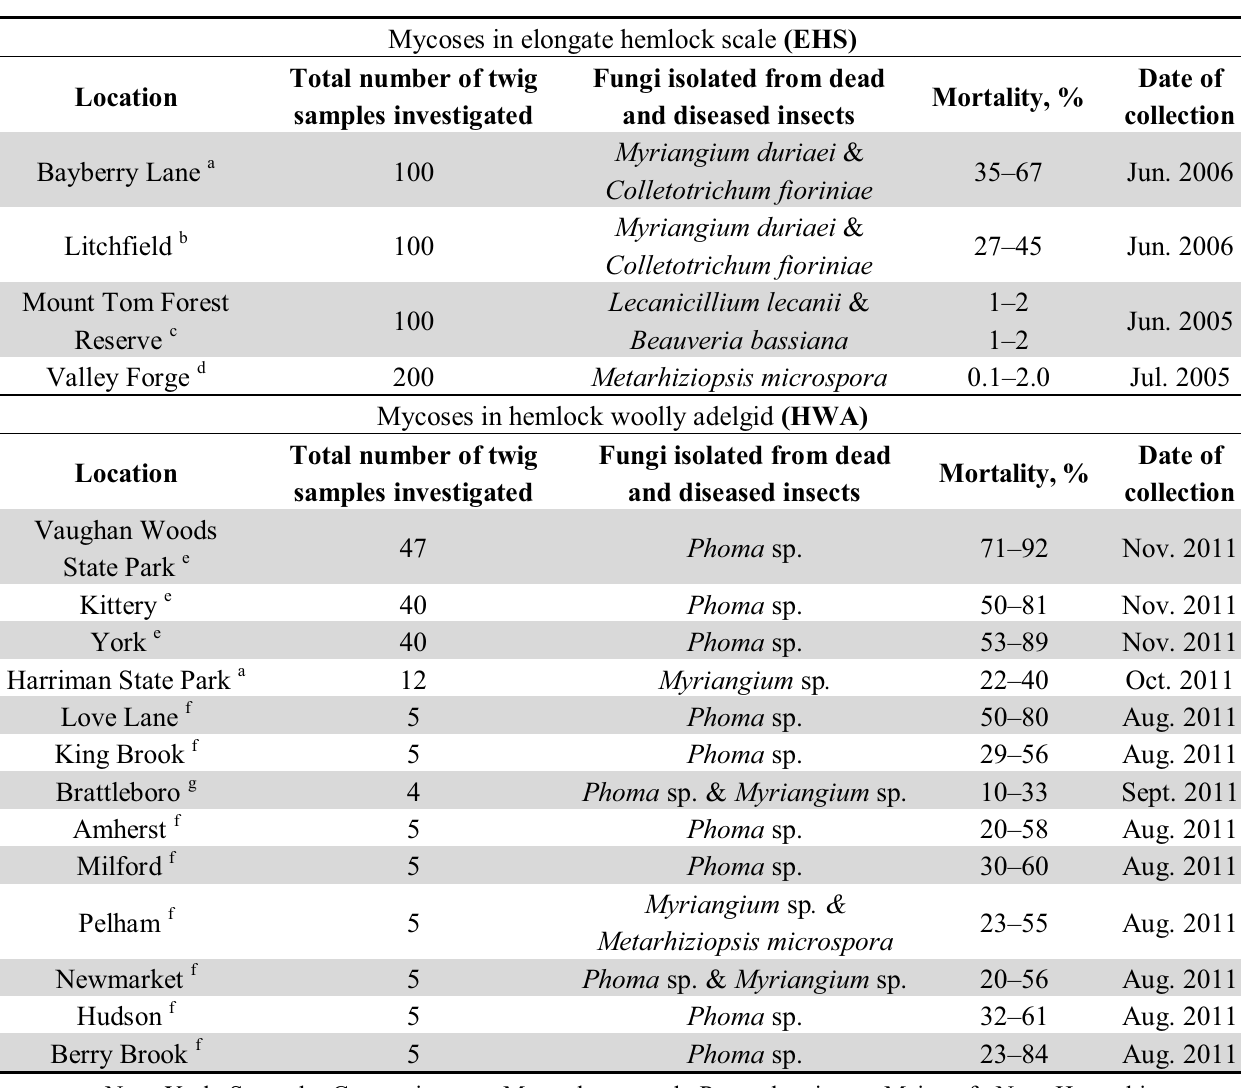
Table 1. Natural occurring mycoses in elongate hemlock scale and hemlock wooly adelgid populations on 25 (cid:177) 30 cm long